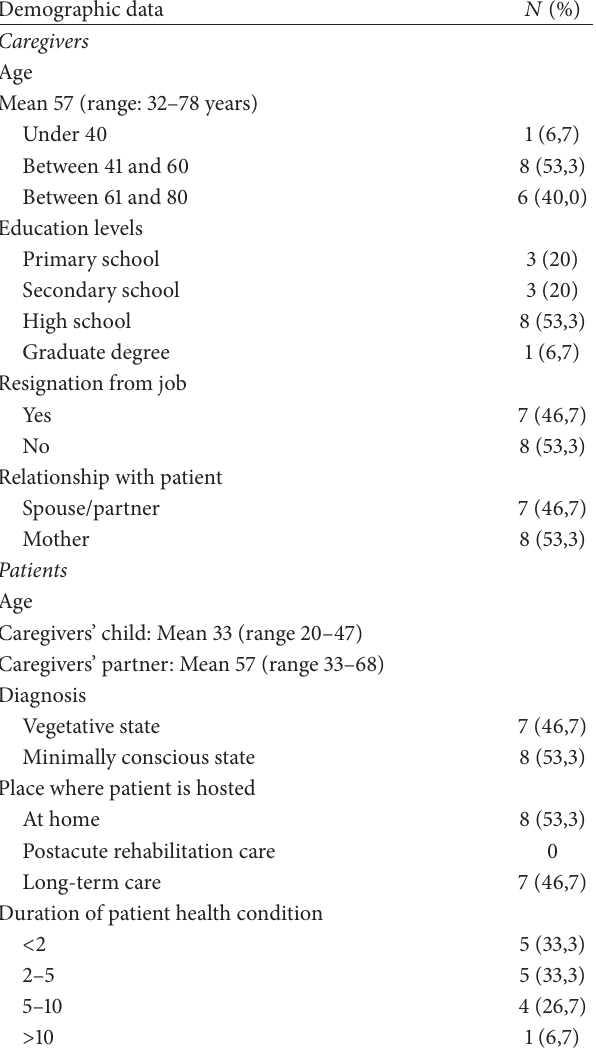
Table 1: Demographic data on caregivers and their